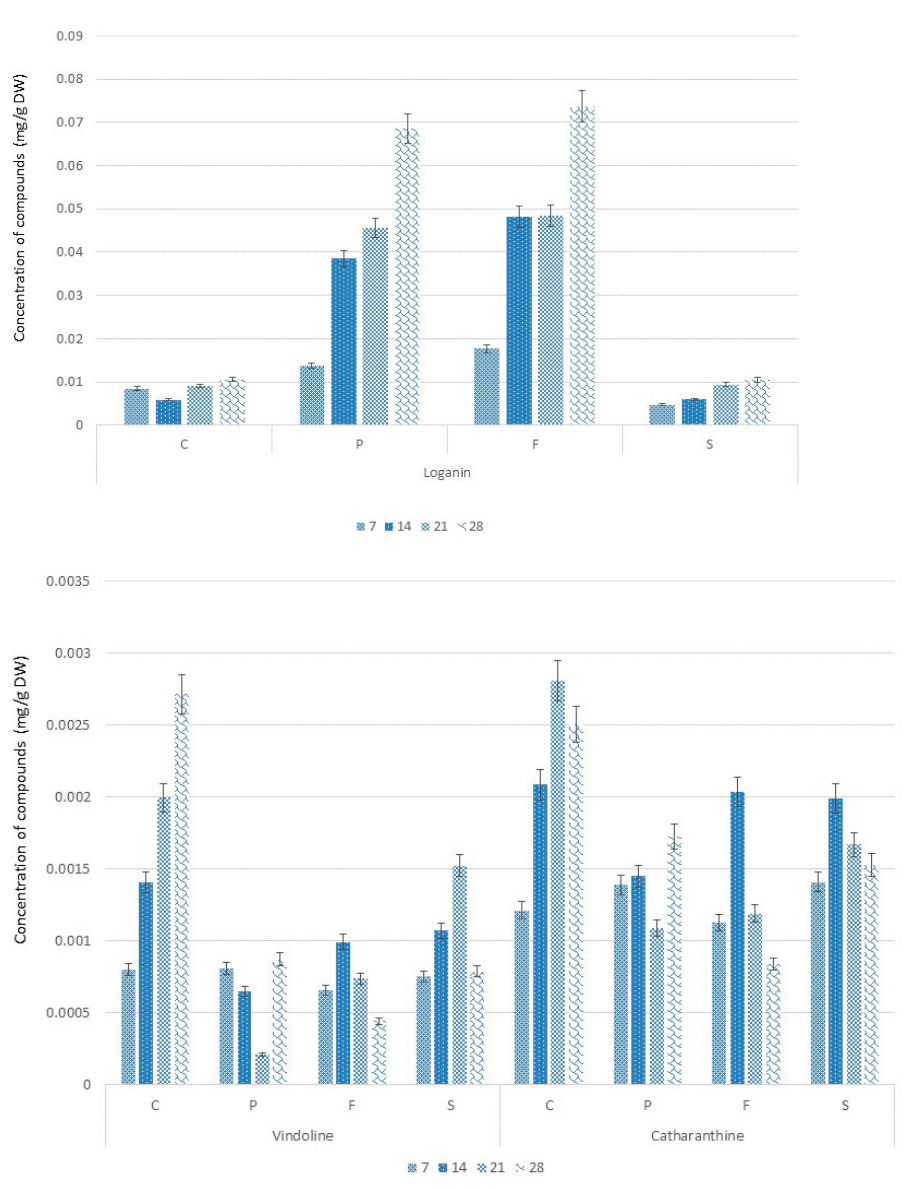
Figure 2. HPLC analysis of the effect of fungicide treatments (Pronto Plus (P), Folicur (F), and Switch (S)) compared to the untreated (control, C) on the concentration of loganin, catharanthine, and vindoline accumulation in Catharanthus roseus . The numbers correspond to harvesting time (7, 14, 21, and 28 days after treatment) and the letters to fungicides (P—Pronto Plus, F—Folicur and S—Switch) and control—C. Data present the average and standard deviation of triplicates for each time point of each